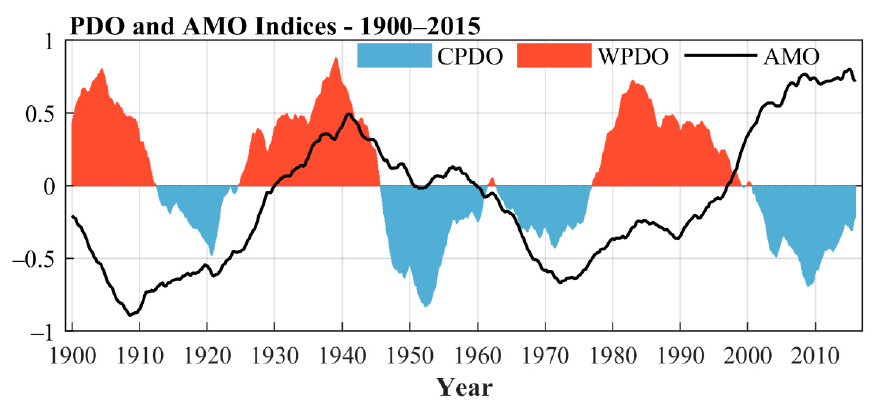
Figure 2. The AMO and PDO indices for the 1900–2015 period. The AMO index was multiplied by three, and its unit is °C. The continuous ticker line is the AMO index, and the red and blue refer to the PDO index.